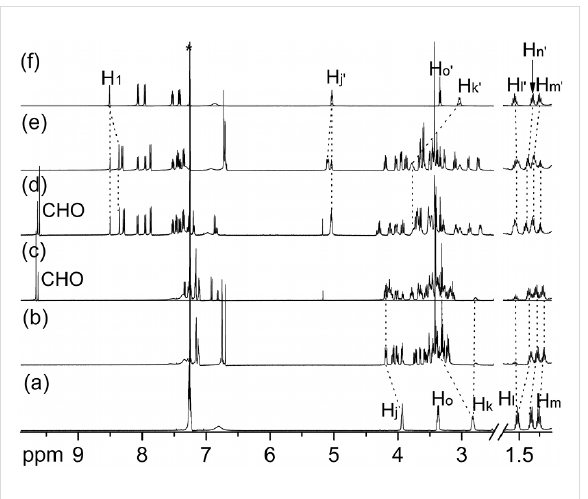
Figure 5: 1 H NMR spectra (500 MHz, 298 K, CDCl 3 :CD 3 CN = 2:1, 10.0 mM) of ( a ) 6 -H•PF 6 , equimolar mixtures of ( b ) 6 -H•PF 6 and C7